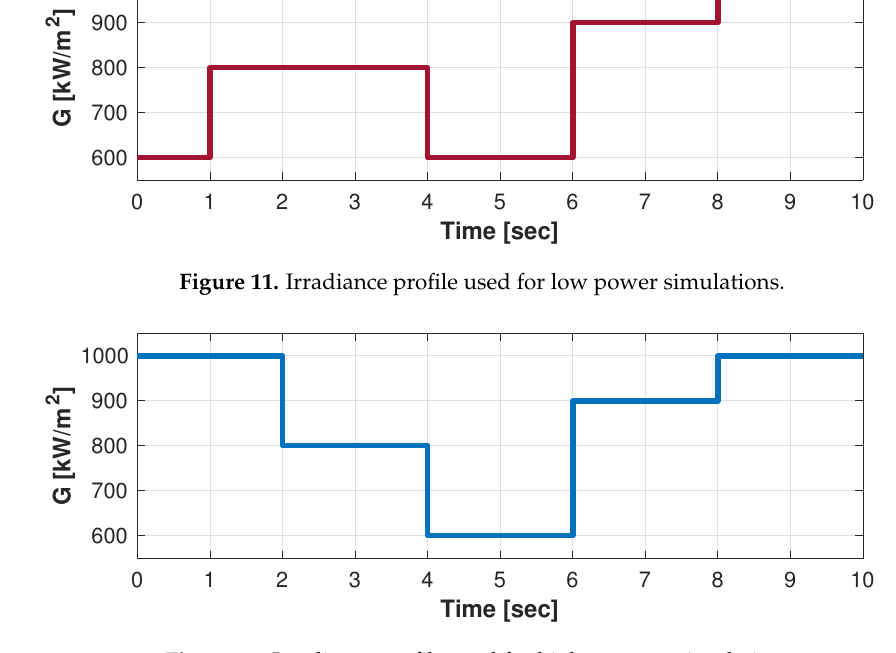
Figure 12. Irradiance profile used for higher power